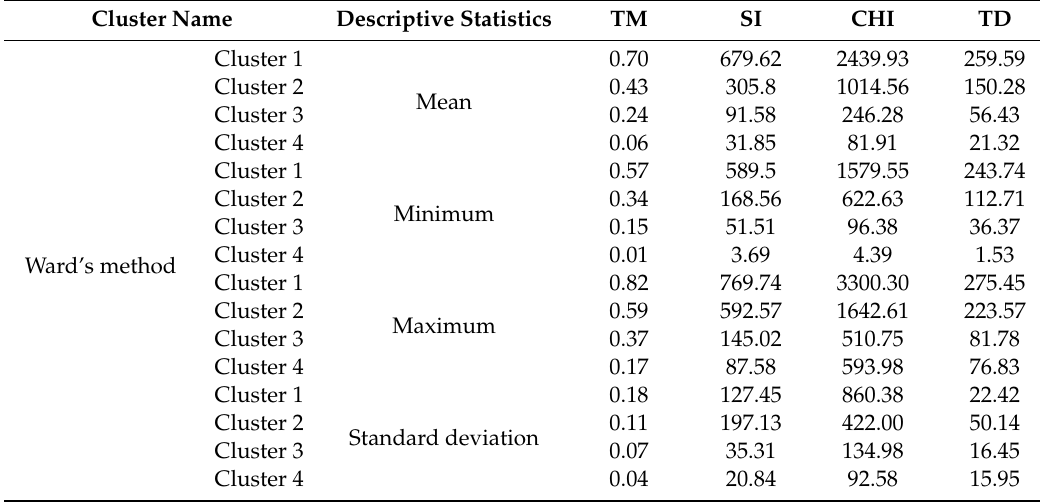
Table 4. Descriptive characteristics of the